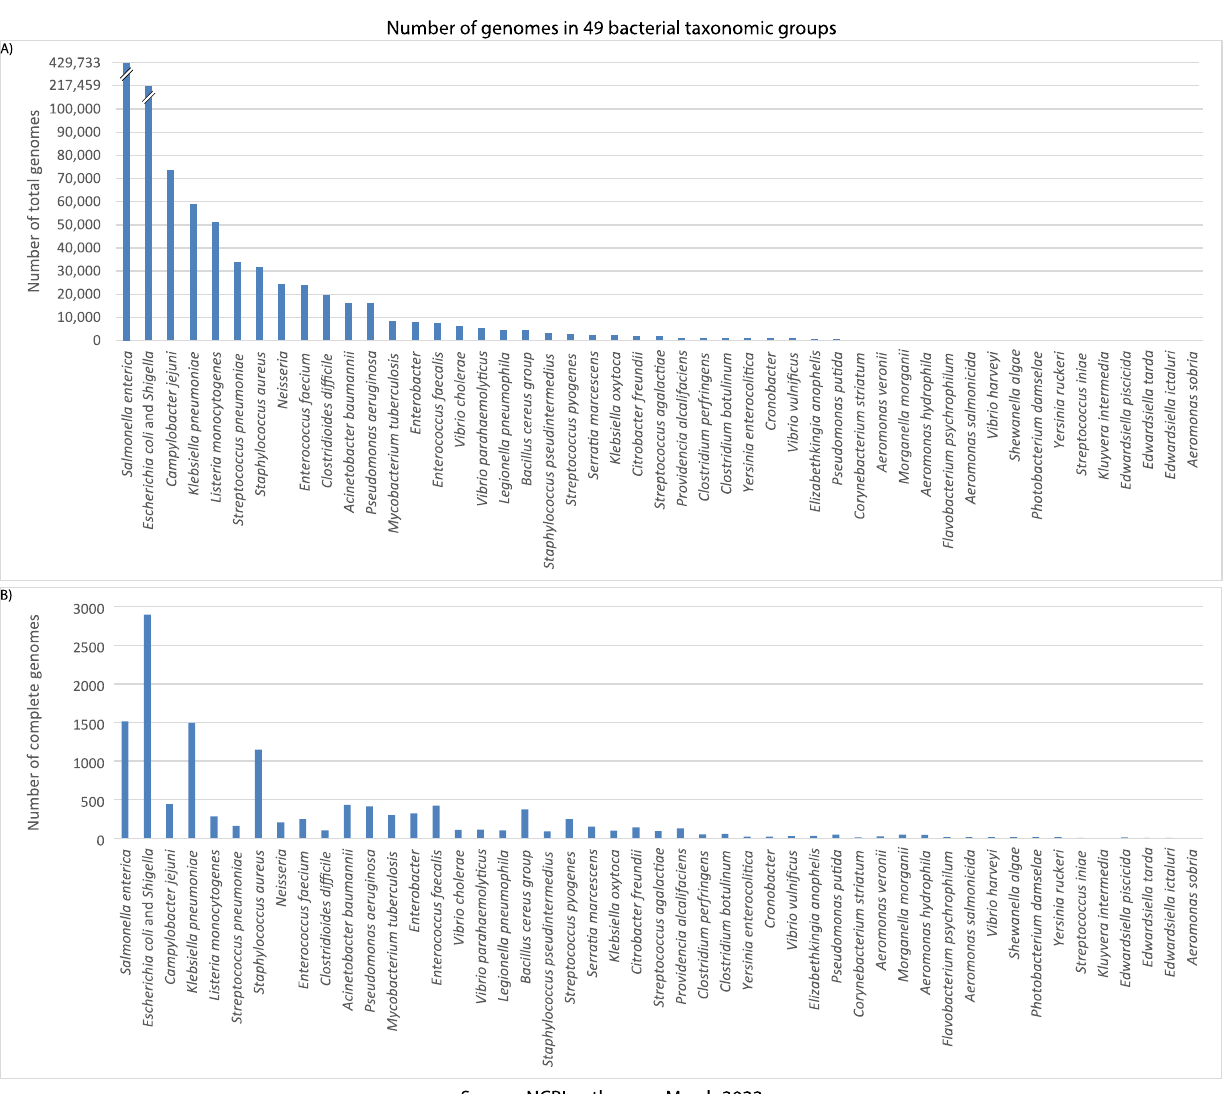
Figure 2. The number of genomes in each bacterial taxonomic group of the NCBI pathogens. ( A ) The total number of genomes reported in each taxonomic group. ( B ) The number of complete genomes in each taxonomic group.